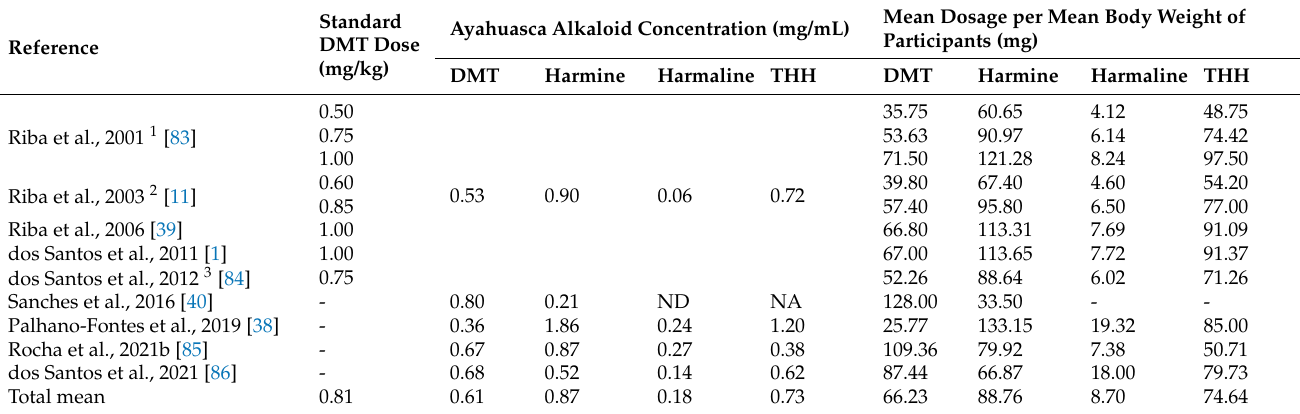
Table 3. Ayahuasca’s alkaloid concentrations and dosages from clinical trials with